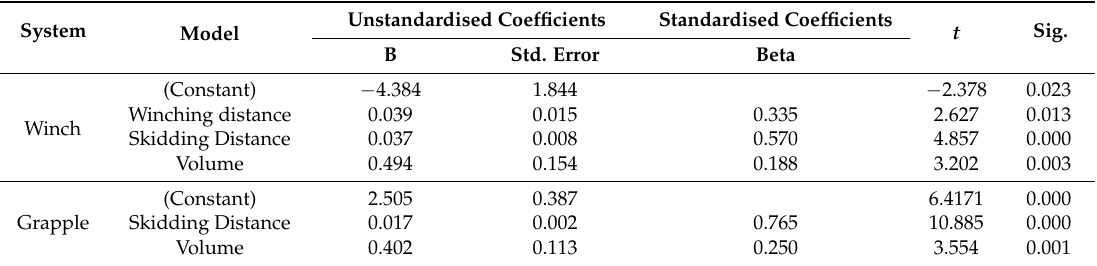
Table 5. Statistical characteristics of regression analysis-based